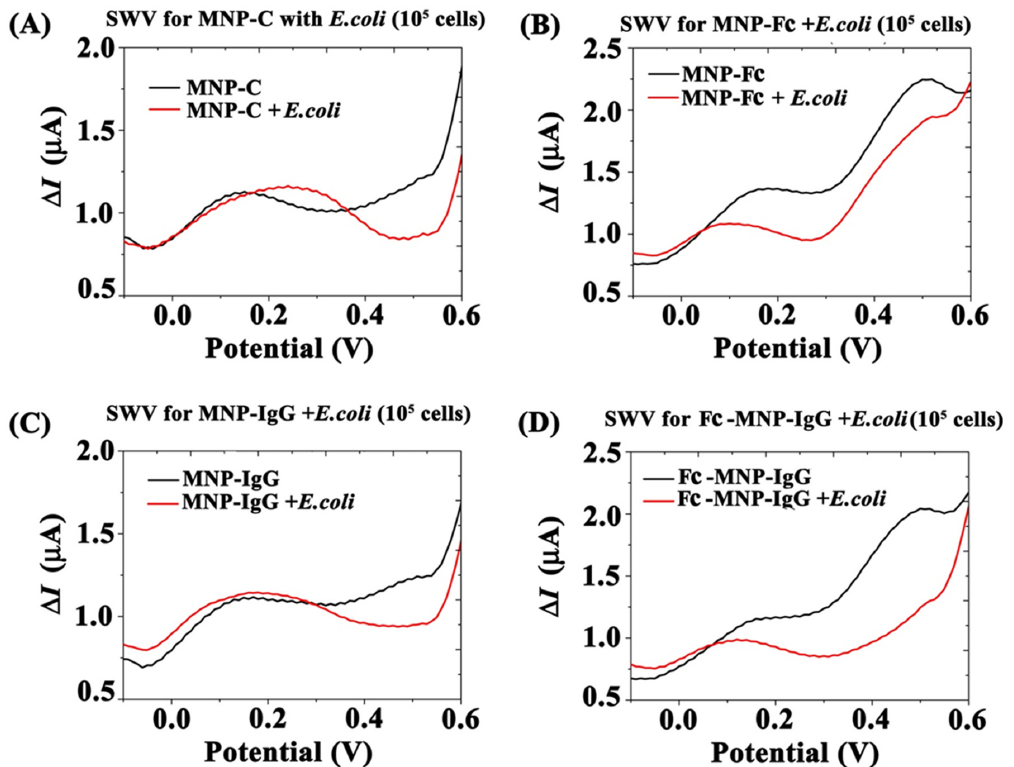
Figure 6. SWV detection of E. coli (10 5 cell/mL) using different MNPs conjugates under a magnetic field. ( A ) SW voltammogram of MNP-C and MNP-C + E. coli (10 5 cell/mL). ( B ) SW voltammogram of MNP-Fc and MNP-Fc + E. coli (10 5 cell/mL). ( C ) SW voltammogram of MNP-IgG and MNP-IgG + E. coli (10 5 cell/mL). ( D ) SW voltammogram of Fc-MNP-IgG and Fc- MNP-IgG + E. coli (10 5 cell/mL). Black color indicates MNP conjugates without E. coli and red color indicates with E. coli . SWV parameters: amplitude 0.1 V; scan increment 0.01 V; frequency 20 Hz and duration 4s.